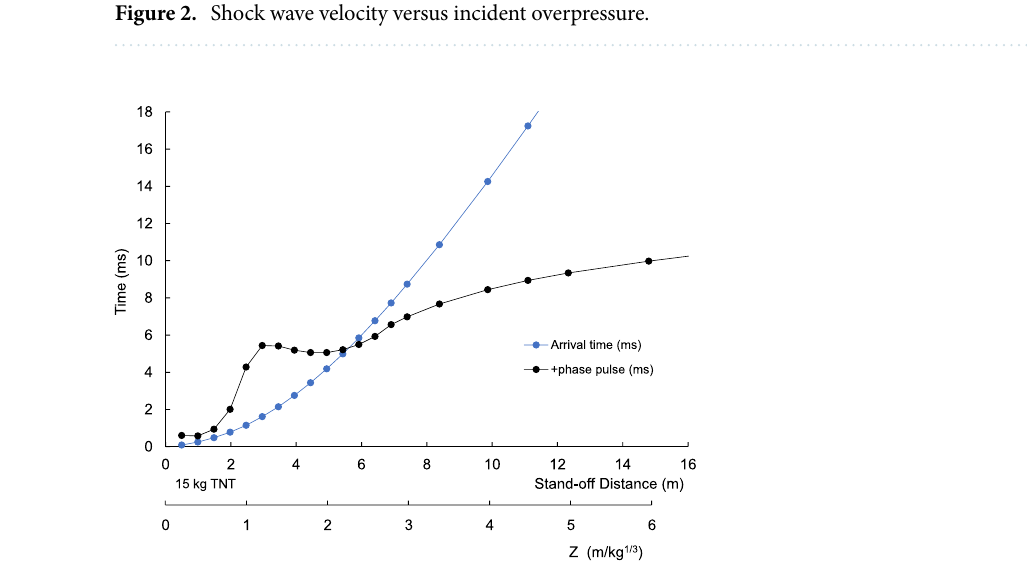
Figure 3. Shock wave arrival time (t a ) and positive pulse duration (t 0 ) with stand-off